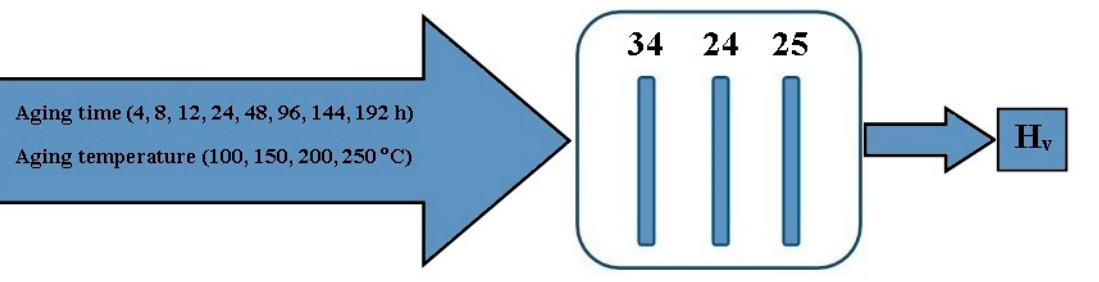
Figure 3. Block diagram of ANN based modeling.